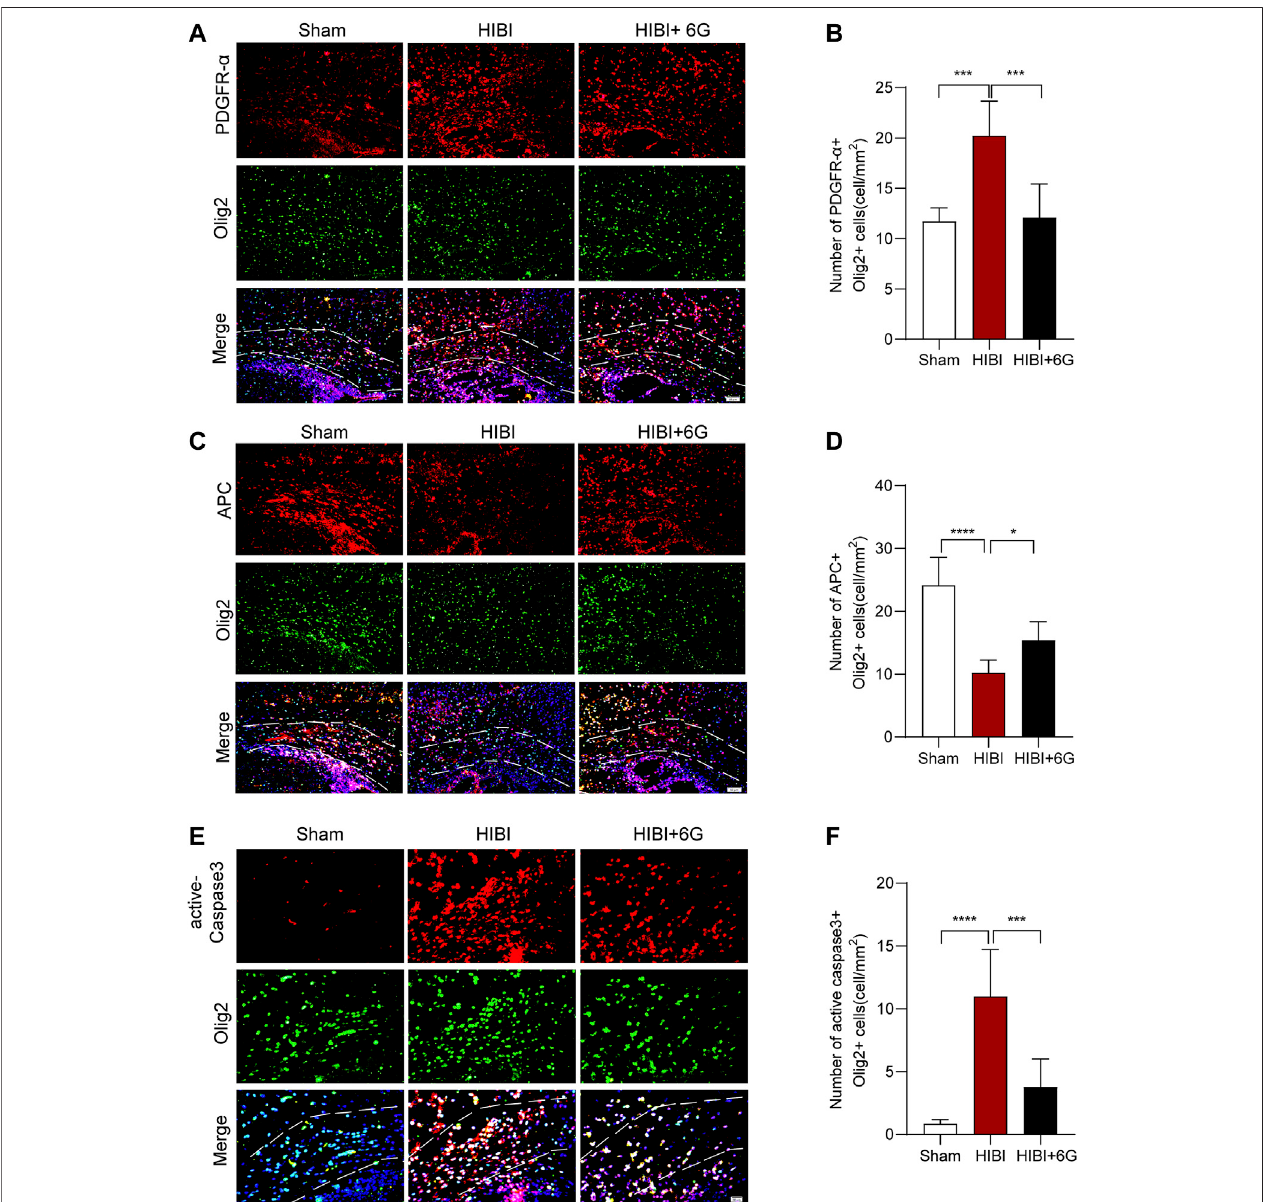
FIGURE 6 | 6-Gingerol stimulates the maturation of oligodendrocytes and reduces the apoptosis of oligodendrocytes. (A) Representative PDGFR- α stained (red) andOlig2stained(green)brainsectionsofthecallosumat3-daypost-HIBI.Scalebar (cid:1) 50 μ m. (B) QuantitativeanalysisofthepercentageofPDGFR- α + Olig2 + cellsinthe callosum. (C) Representative APC stained (red) and Olig2 stained (green) brain sections ofthe callosum at 3-day post-HIBI. Scale bar (cid:1) 50 μ m. (D) Quantitative analysis ofthepercentage ofAPC+Olig2 + cellsinthecallosum. (E) Representativeactive-Caspase3stained(red)